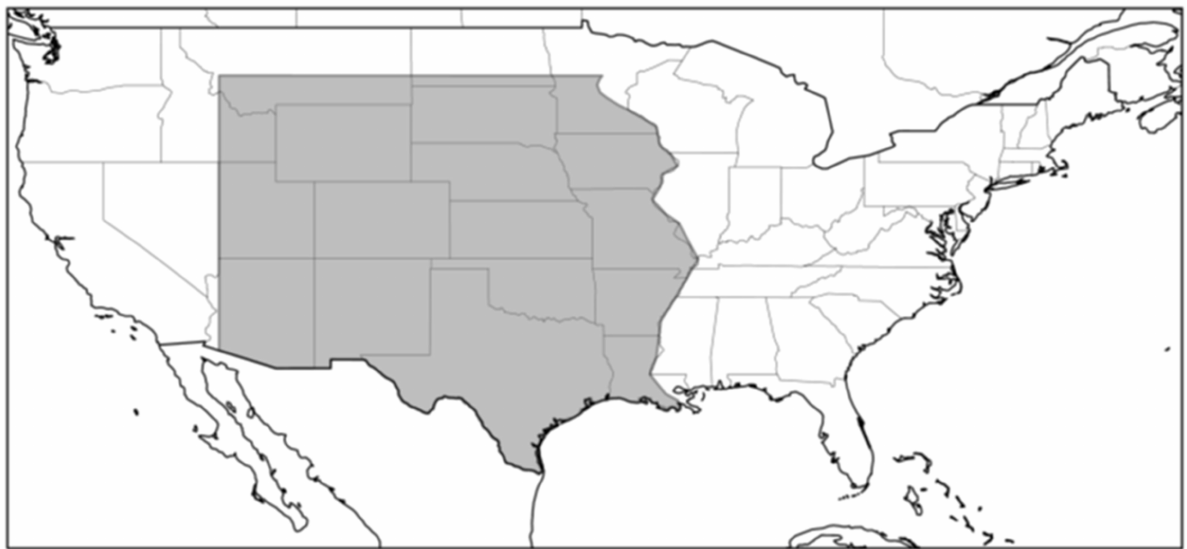
Figure A1. General circulation model (GCM) evaluation area shown in gray shading. The area was chosen to encompass most historical VS occurrence locations, to ensure that the GCMs simulate realistic historical climate. The area extends approximately from the Mississippi River on the eastern boundary to 114 degrees W longitude and from the US southern border to 46.5 degrees N